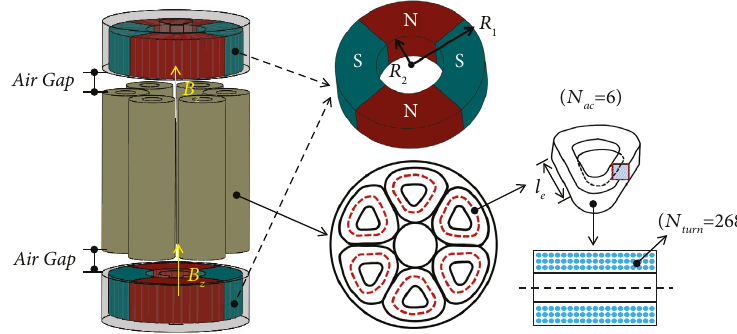
Figure 2: Structural parameters of the joint mechanism.